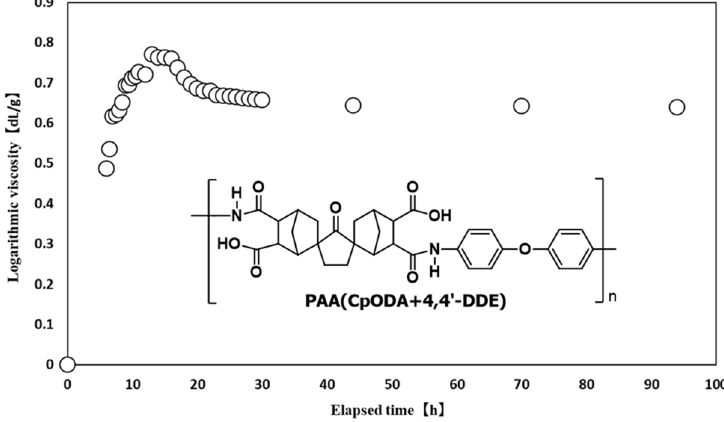
Figure 1. The variation in the logarithmic viscosity of the PAA with elapsed time since adding CpODA into the 4,4 ′ -DDE solution.